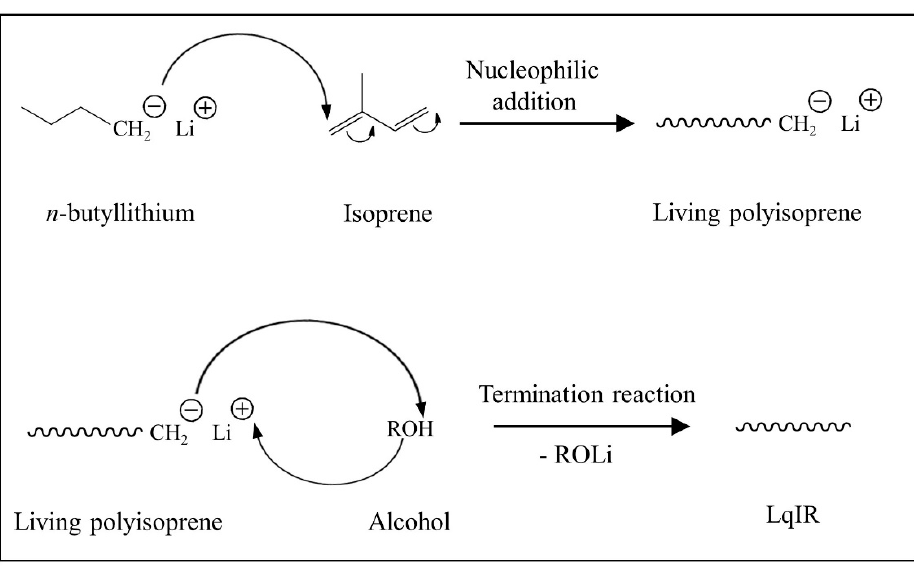
Scheme 2. Polymerization of LqIR.